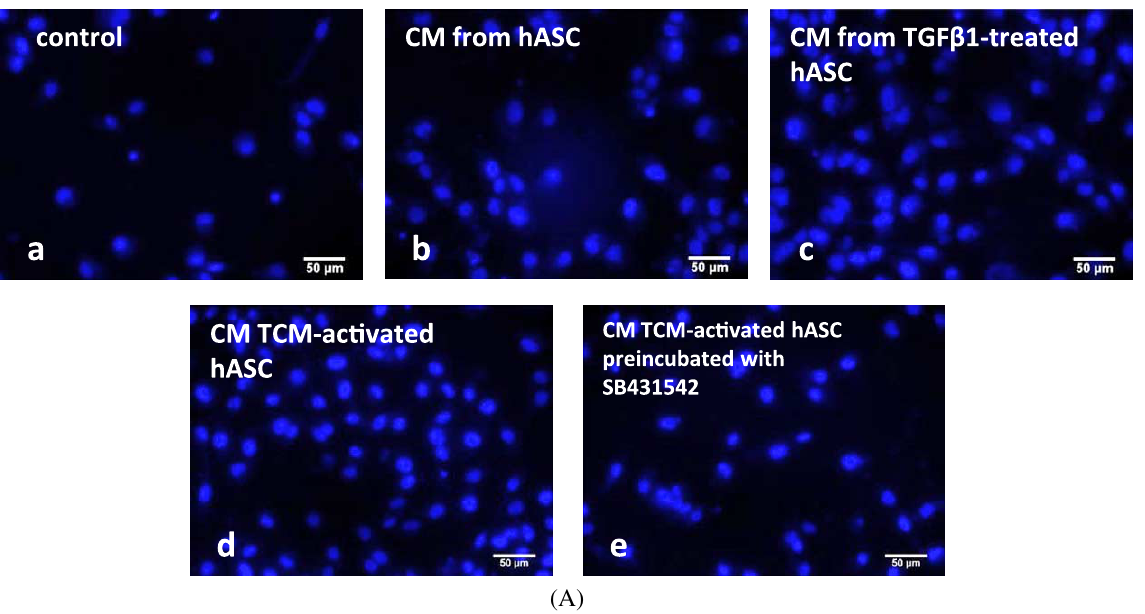
Fig. 7. Conditioned medium from both rTGF β 1-treated hASCs and CAF-like hASCs promotes tumor cell invasion. (A) Fluorescent images of MDAMB231 cancer cells that invaded into matrigel after 40 h. The nuclei of the invaded cells were stained with the nuclear dye Hoechst 33342 and appear blue. Images show invaded cancer cells when cultured in (a) regular medium containing 5% FBS, (b) CM from hASCs, (c) CM from rTGF β 1-treated hASCs, (d) CM from “CAF-like” hASCs and (e) CM from “CAF-like” hASCs pretreated for 30 min with 10 µM SB431542 (tyro- sine kinase inhibitor). Representative pictures of three independent experiments are shown. Scale bar: 50 µm. (B) Hoechst-positive MDAMB231 cancer cells were counted in five independent view fields in each group and are shown as mean ± SD. Experiments were repeated at least three times. * P < 0 . 001; ** P < 0 . 005; *** P < 0 . 0001. CM – conditioned medium; rTGF β 1 – recombinant transforming growth factor beta 1. (The colors are visible in the online version of the